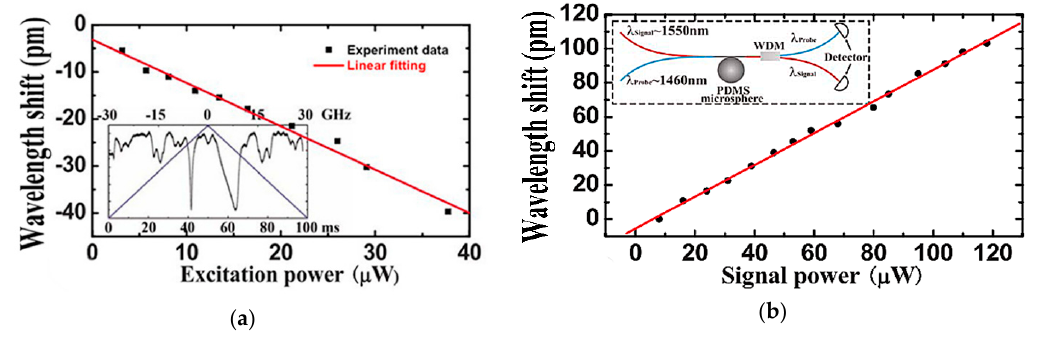
Figure 2. ( a ) Relationship between the wavelength shift and the excitation power in a short period of time (<10 ms); ( b ) resonant wavelength shift of the probe WGM ( λ 0 = 1460 nm) vs the signal power.